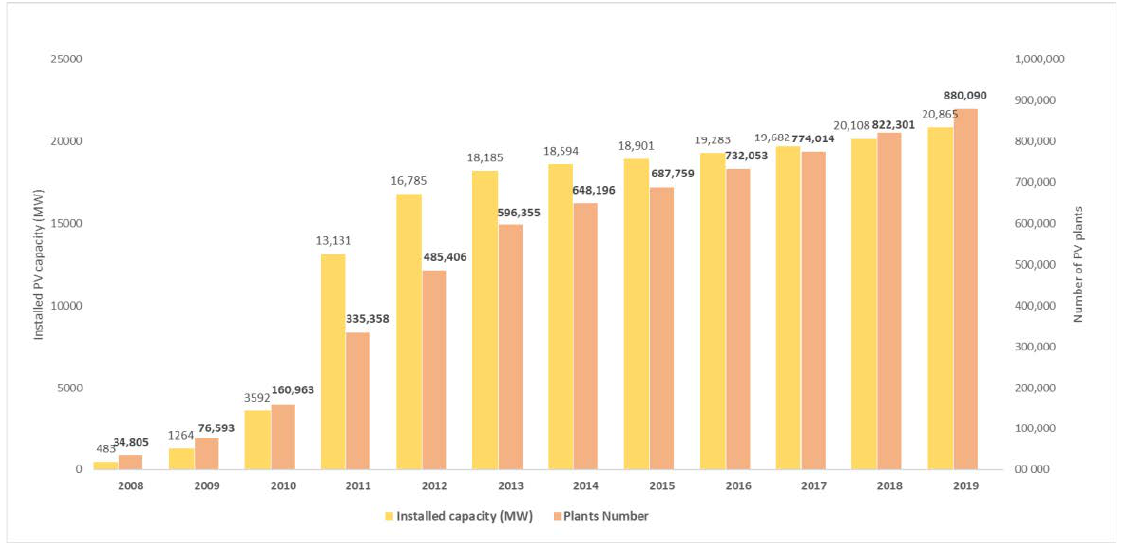
Figure 7. Evolution of photovoltaic installations in Italy [36].